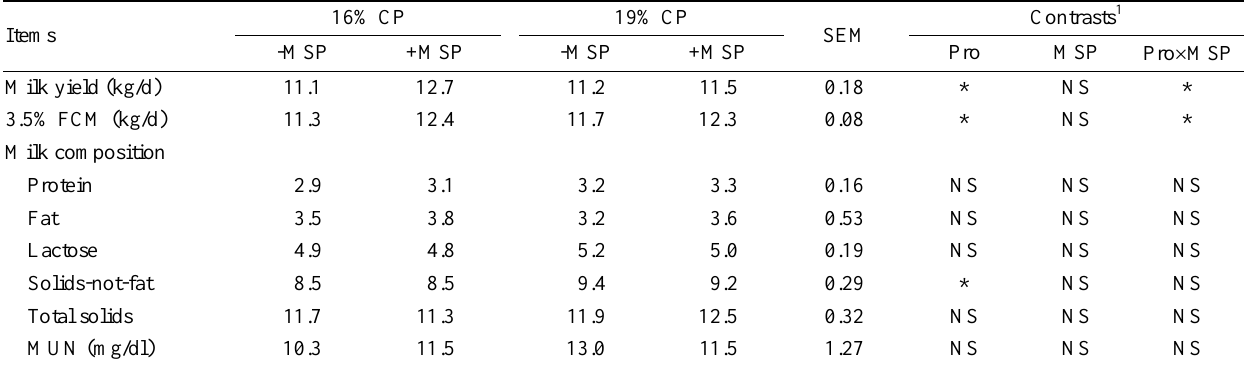
Table 7. Effect of protein level and mangosteen peel pellets (Mago-pel) in concentrate diet on milk yield, milk composition and milk urea nitrogen